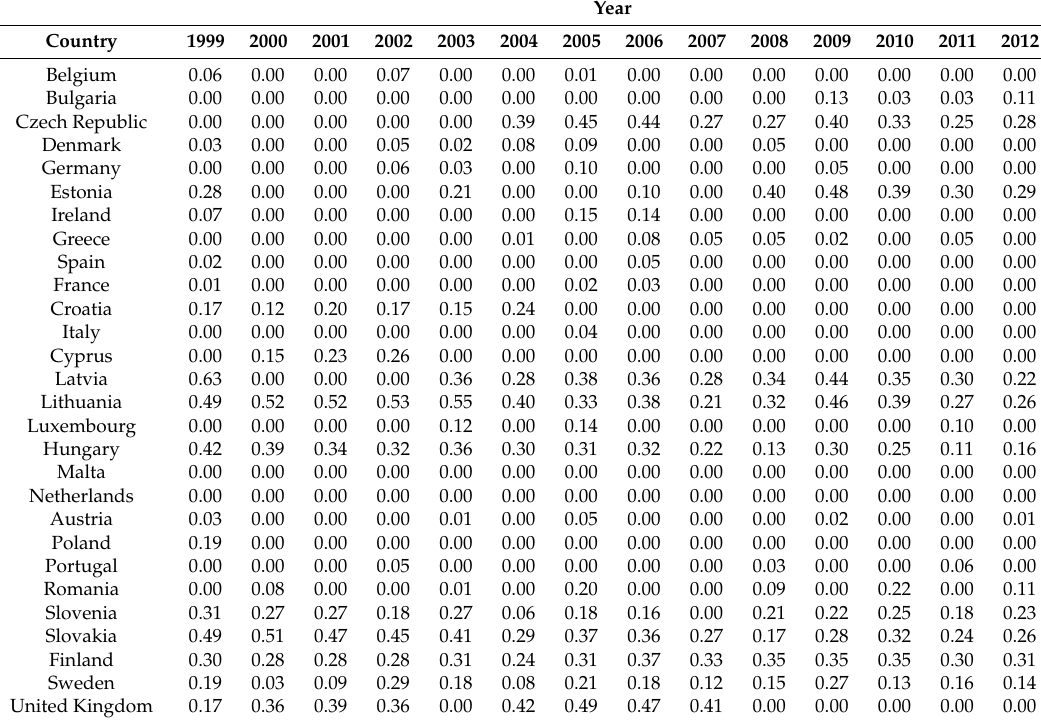
Table A1. Annual Eco-(in)efficiency scores of EU agricultural sector